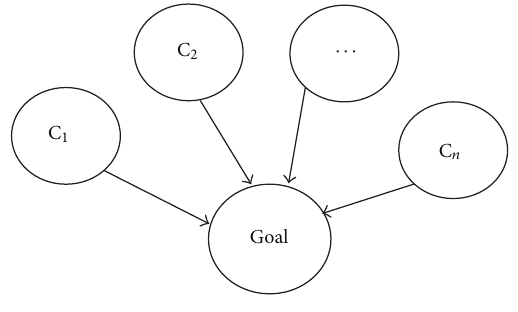
Figure 4: Simple example of a BBN